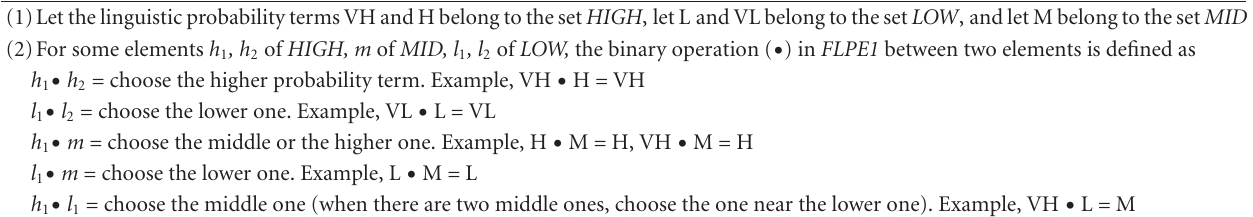
Table 4: The heuristic knowledge for building the FAM in Table 3.